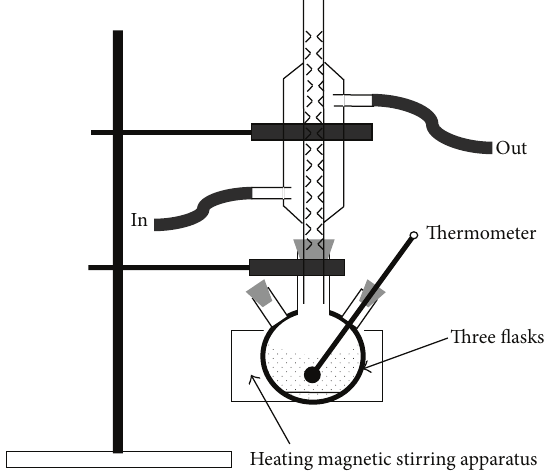
Figure 1: Synthesis schematic of amorphous MnO 2 /graphene